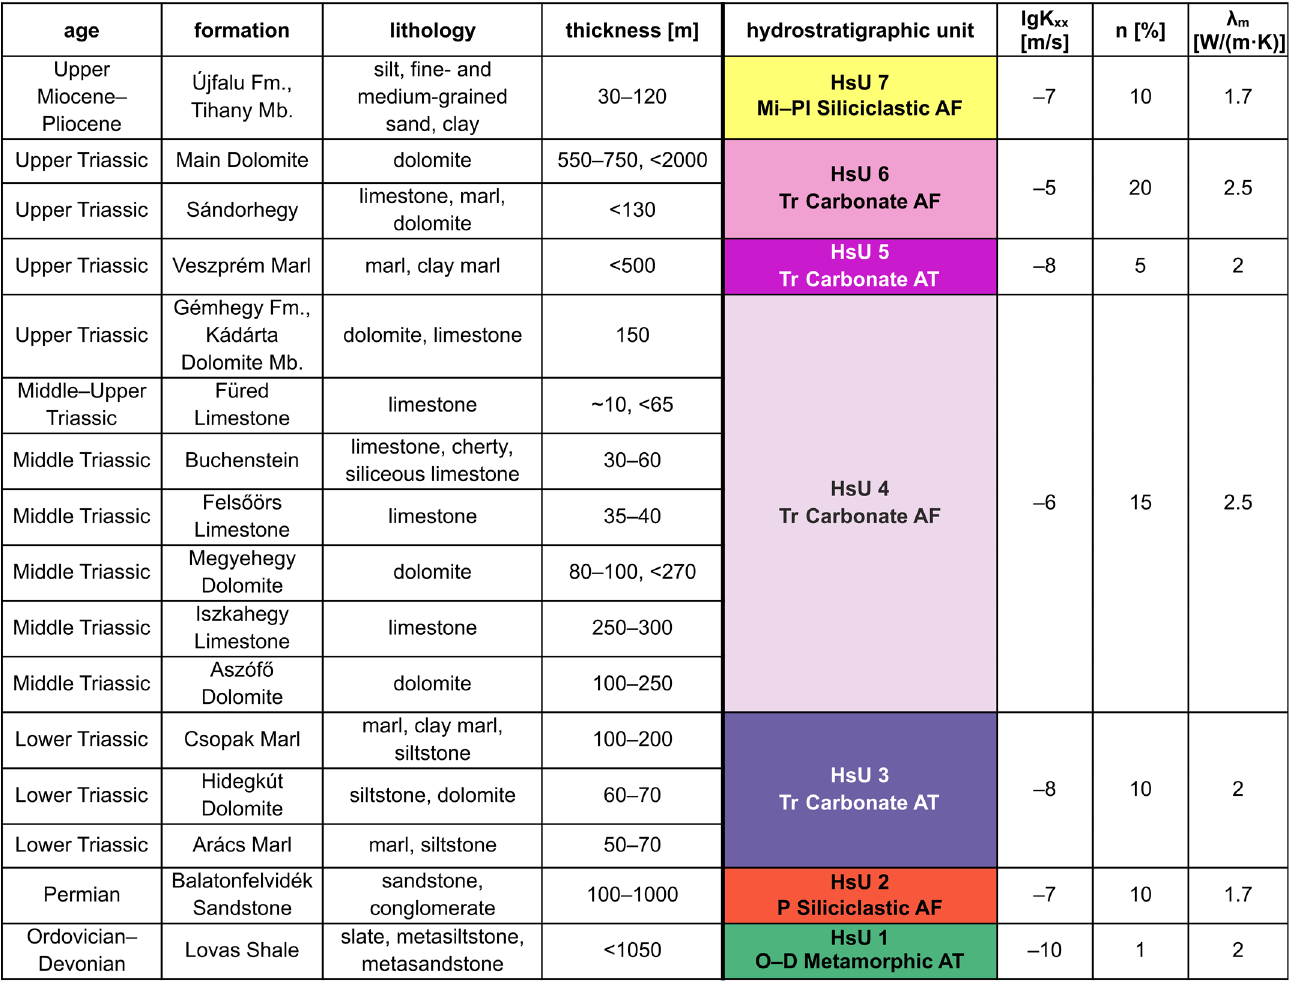
Figure 2. Hydrostratigraphic units and their characteristics for the Balaton Highland region.